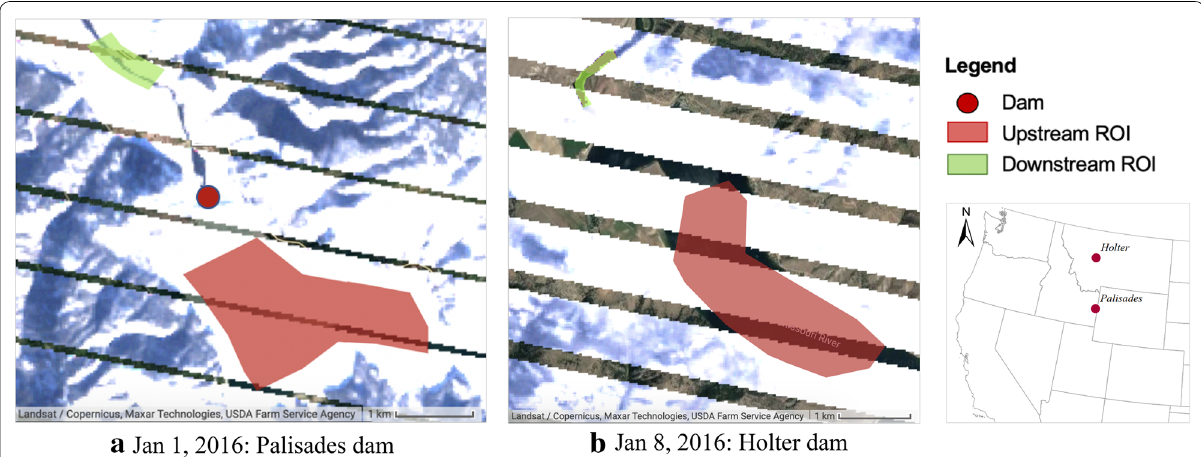
Fig. 9 Landsat ETM images showing a sheet of ice forming on top of reservoir surface during winter season, resulting in sub-zero surface radiant + temperatures for two dams. Green and red polygons (regions of interest; ROI) were used for obtaining average temperatures downstream and upstream,